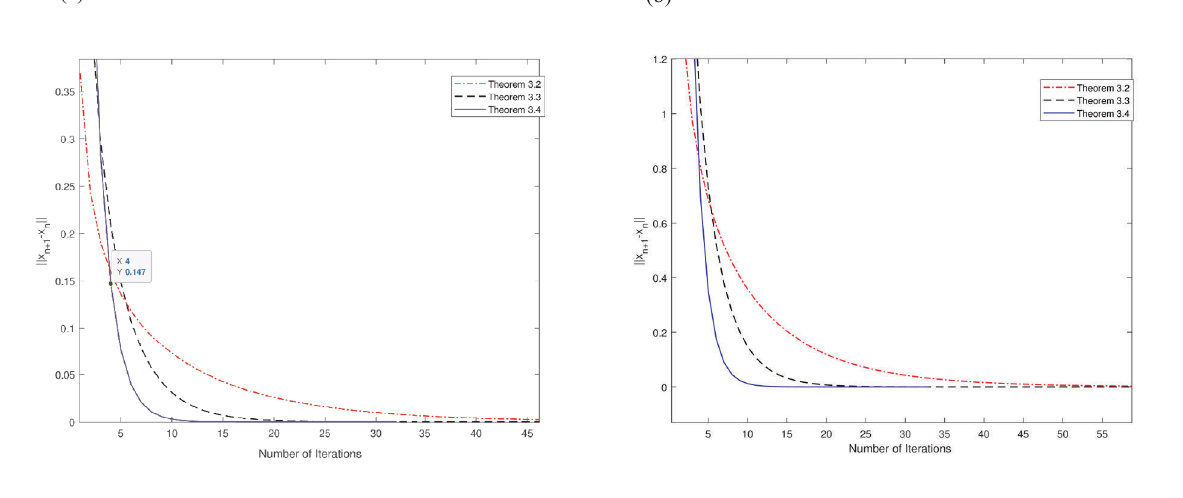
Fig. 1. Error plots for first (a), second (b) and third (c) choice.